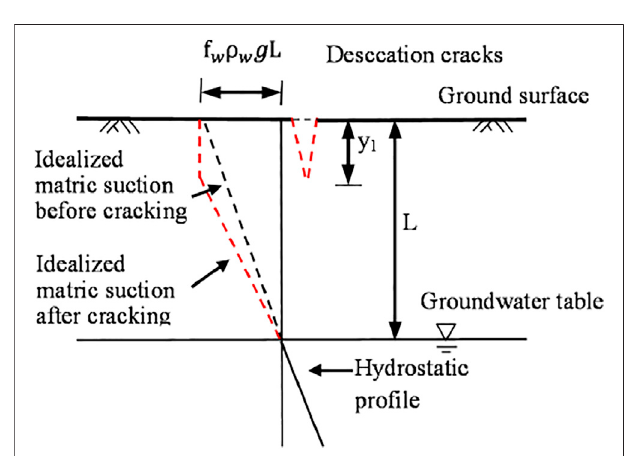
FIGURE 8 | Distribution of the matric suction during the drying